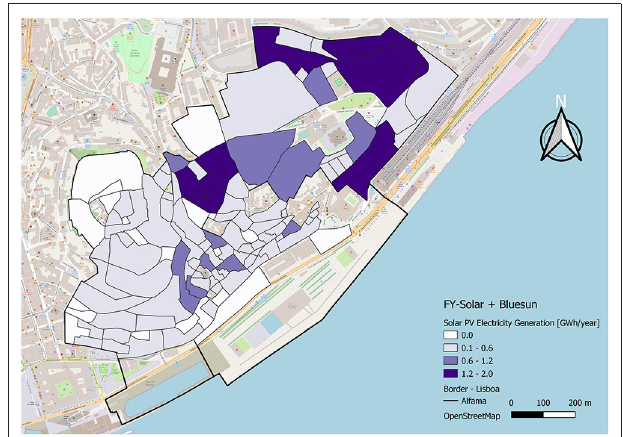
FIGURE 7 | Total solar PV electricity generation technical potential (rooftop and windows) for residential buildings in Alfama.